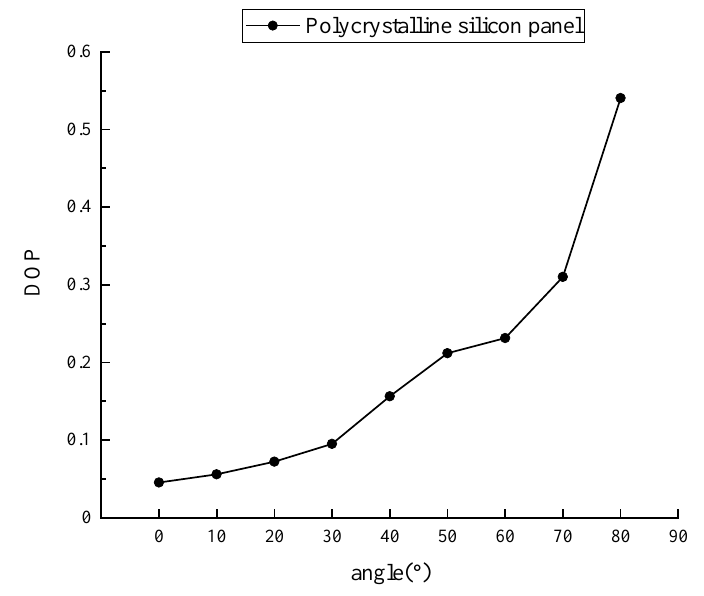
Figure 12. Curve of DOP value with view angle.